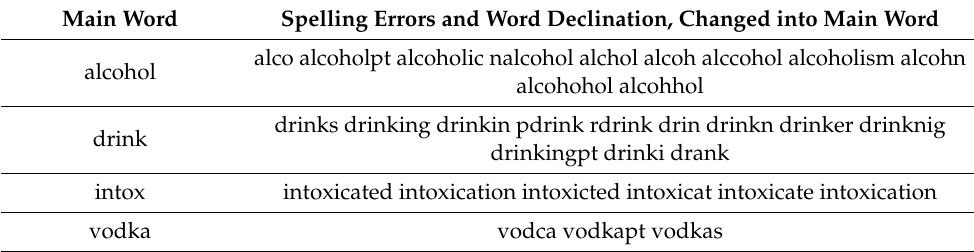
Table A2. Spelling errors and word declination to change into main